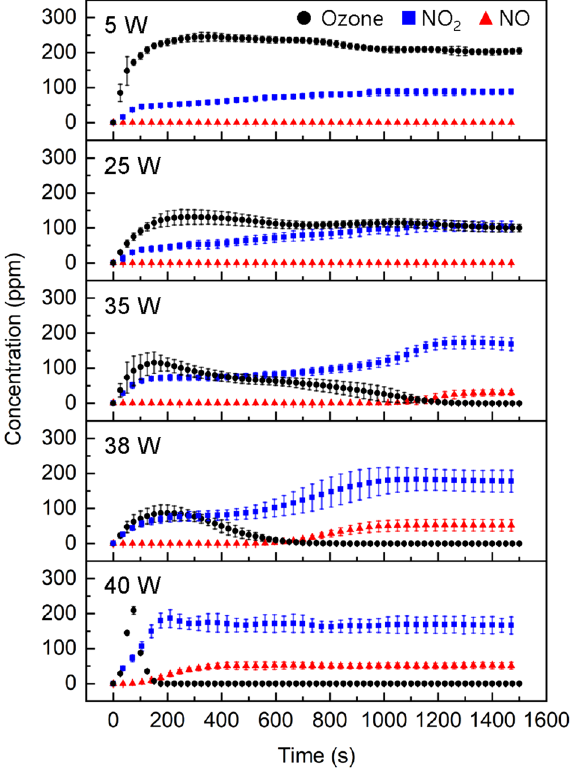
Figure 5. Concentrations of O 3 , NO 2 , and NO produced by FXDBD at different driving powers. Data are shown as the mean and standard deviation from three independent